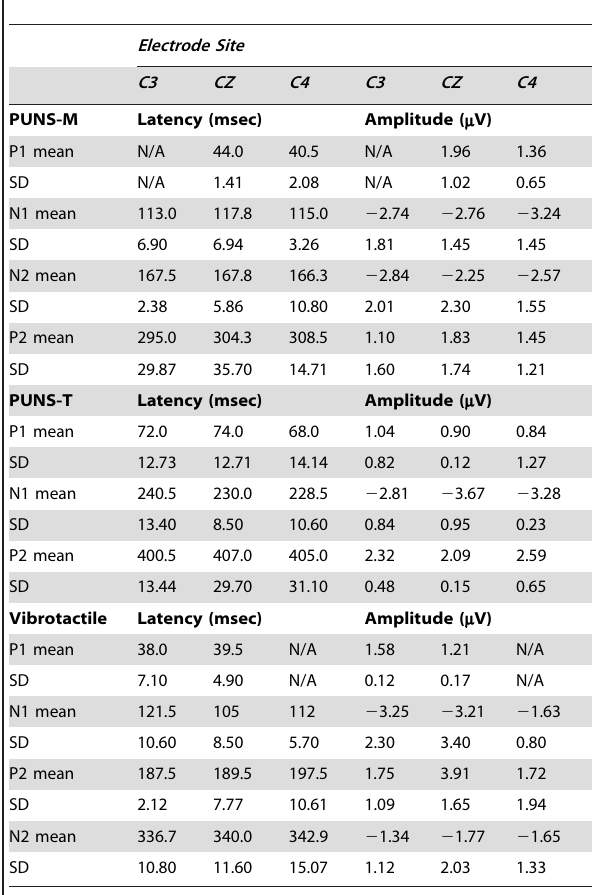
at contralateral electrode sites for both right and left finger stimulation. The mean N2 USEP amplitudes observed for right finger stimulation were 2 2.84 6 2.01 m V and 2 2.57 6 1.55 m V at C3 and C4 electrode sites respectively (Figure 2 and Table 1). For